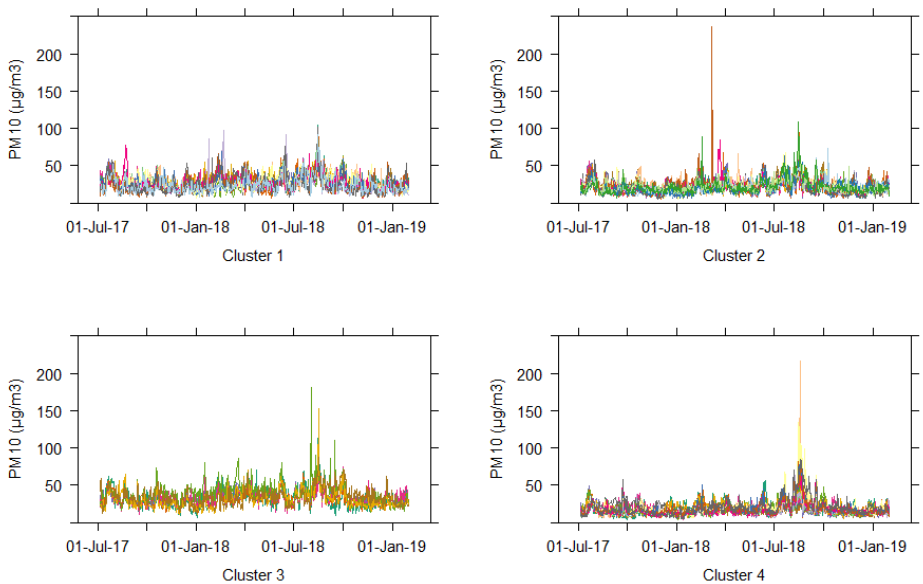
Figure 7. Time series plots for each cluster formed based on DTW and FKM for daily average PM 10 time series data.